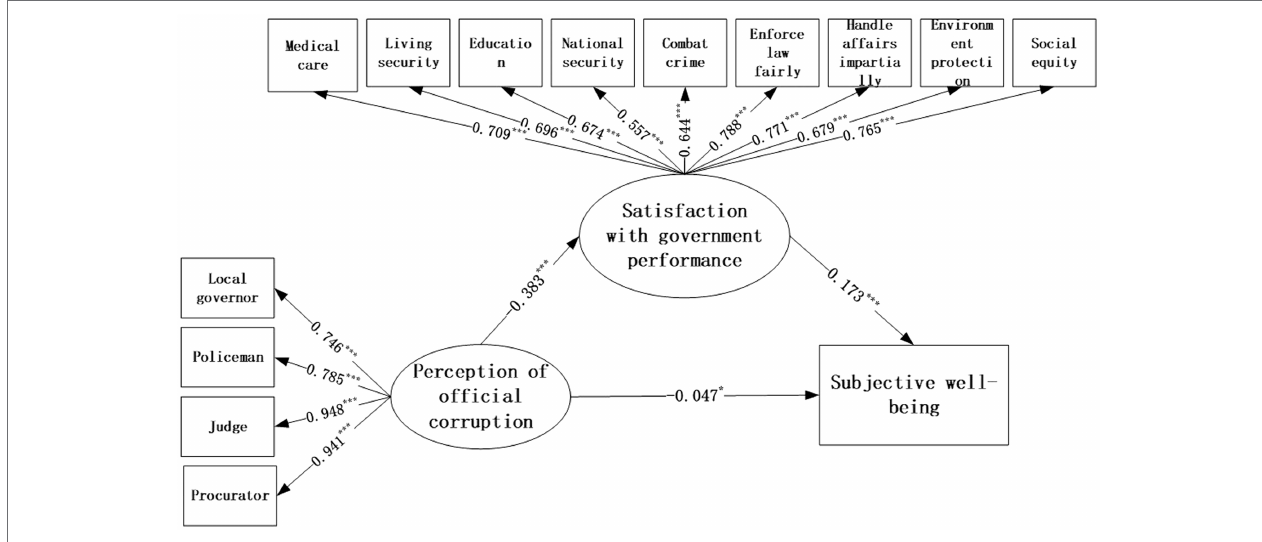
FIGURE 1 | Structural equation modeling results of research model. *** p ≤ 0.001, *** p ≤ 0.01, and * p ≤ 0.05.